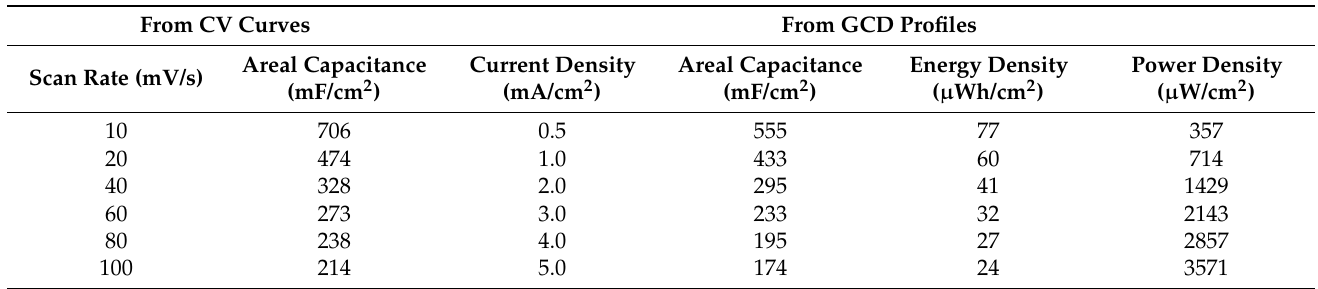
Table 1. Areal capacitances, energy densities, and power densities of the PANI/NF//JAC/NF ASC.